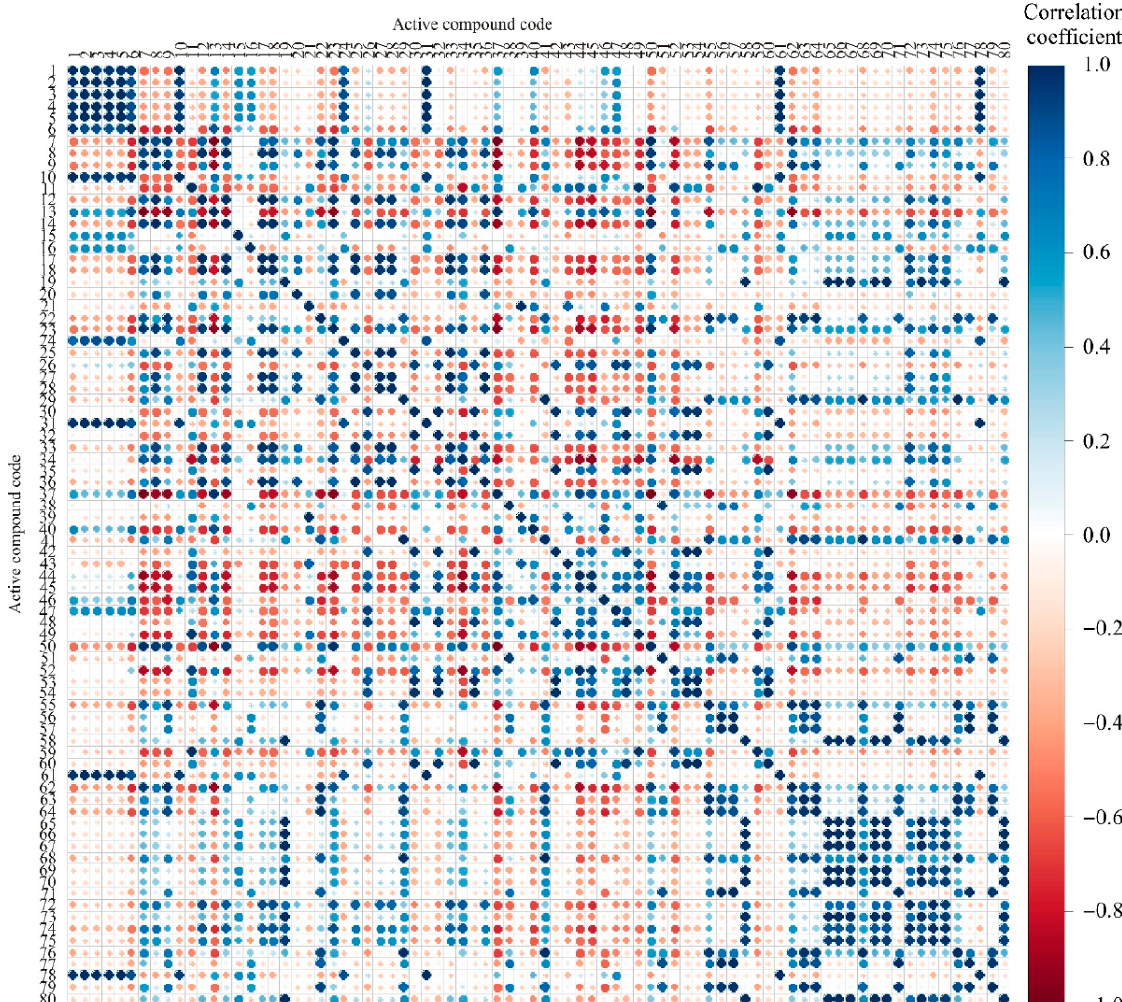
Figure 3. Correlation between active compounds content in hydrolate and essential oil of L. x intermedia cv. ‘Budrovka’ samples from 2019, 2020, and 2021 (active compounds codes are listed in Table 3 and Table 4).